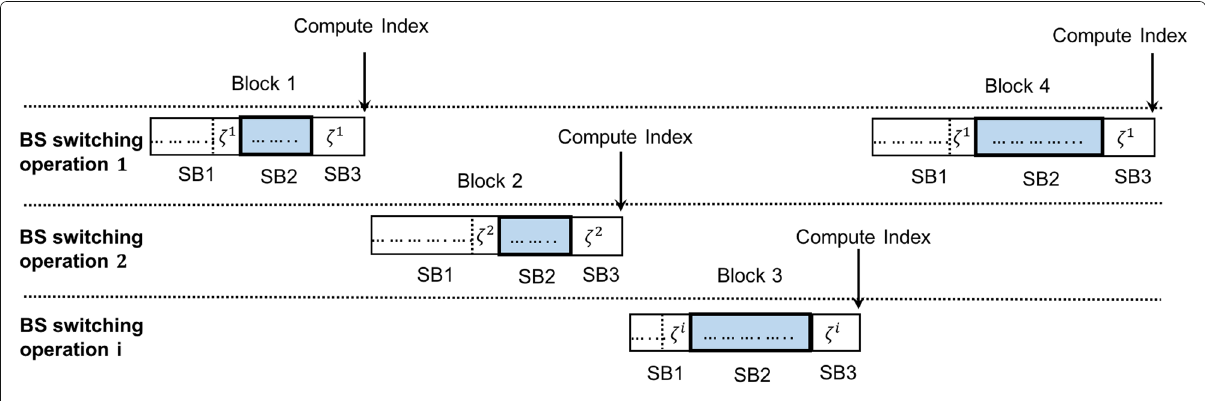
Fig. 2 Regenerative sample path for EEM-UCB. The figure illustrates the sub-division principle of blocks in the learning phase in order to generate a sample path of homogeneous Markov